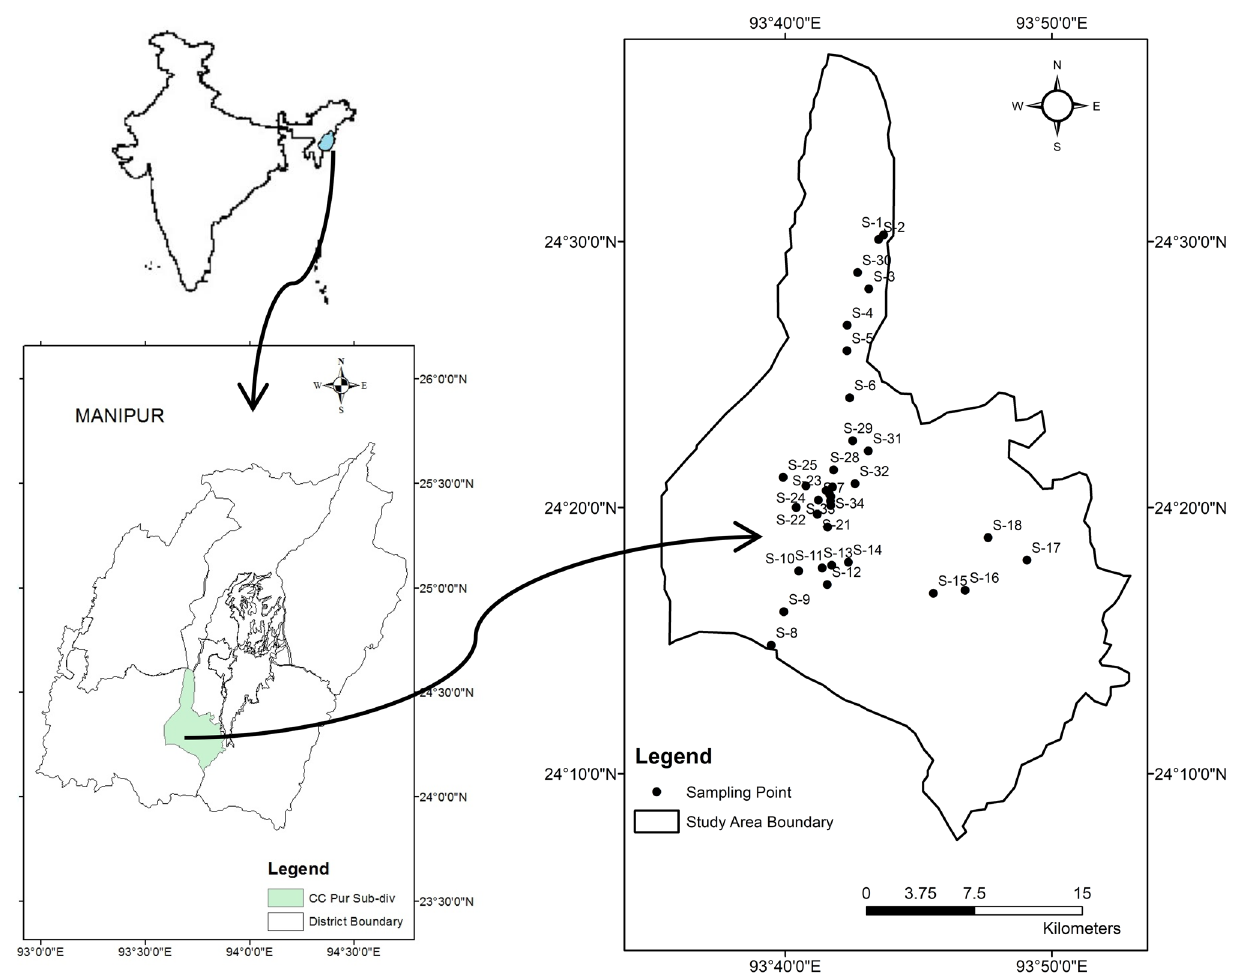
Fig. 1 The geographical location and sampling points of the study